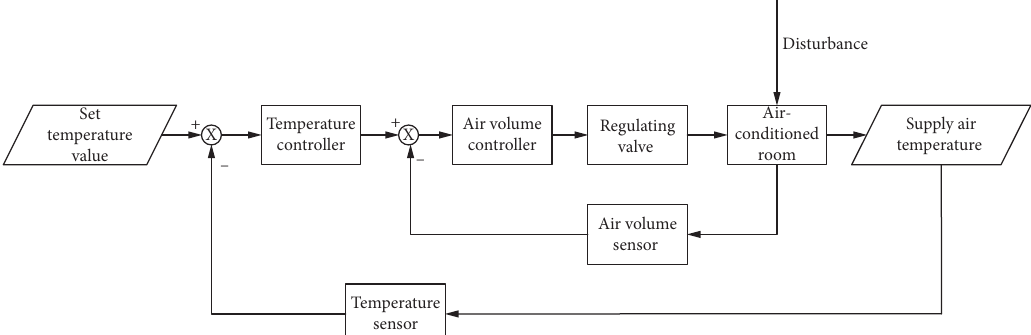
Figure 4: Diagram of the room temperature control of a VAV air-conditioning